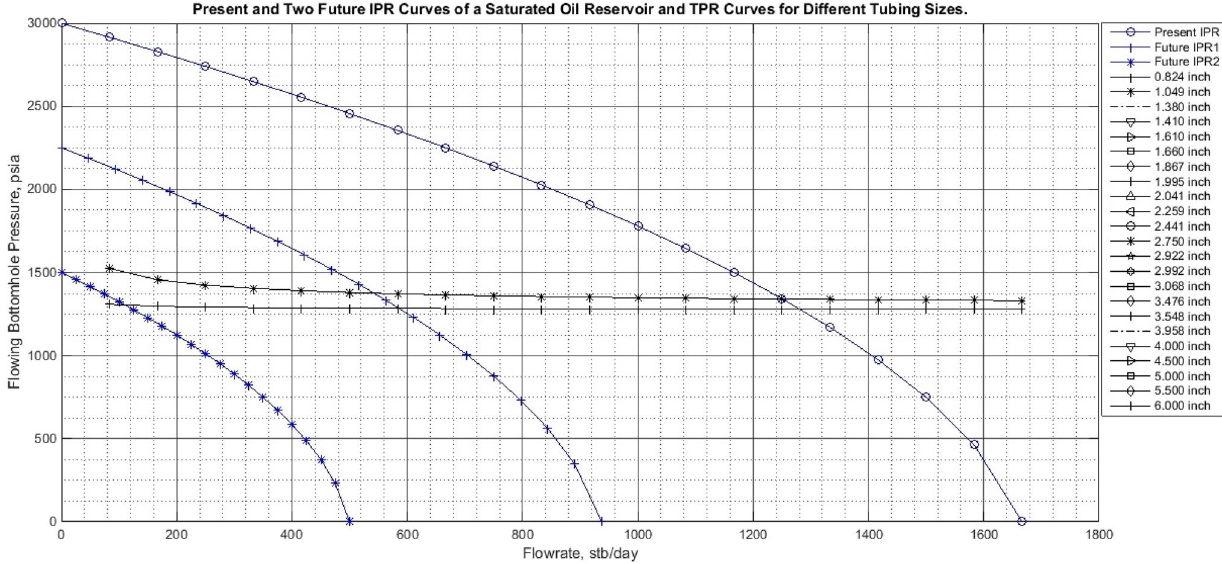
Fig. 4 Comparison of operating rates of selected 2.750-inch OTS and 6-inch tubing size for saturated oil reservoir